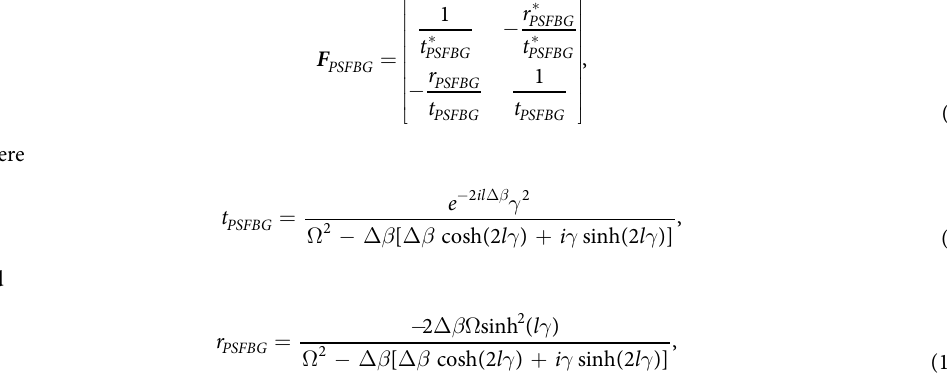
Table 1. The effective refractive index n eff and fiber loss α are 1.468 and 0.0002 dB/m respectively, which are the effective group index of refraction and loss of Corning SMF-28e + ® fiber at 1550 nm. The loss α 0 contains con- nector insertion loss and splice loss. For ordinary FC/APC connectors, these connectors feature a low 0.25 dB connector-to-connector typical loss. The value of α 0 estimates to be a sum of 0.5 dB connector insertion loss (0.25 dB for phase-shifted grating to fiber patch cable and 0.25 dB for fiber patch cable to uniform grating) and 0.5 dB splice loss. The value of grating refractive index modulation amplitude Δ n 0 is 0.0017, length of grating unit l is 0.00128 m and Bragg wavelength λ B is 1.55 μ m, which are the grating parameters we used in later experiment. An integer N is introduced to obtain a symmetrical reflection spectrum. As a characteristic of Fabry-Perot inter- ferometer, the reflection spectrum is symmetrical when the length of fiber (resonant cavity length) is half-integer multiples of half of effective Bragg wavelength in fiber, as described in equation: